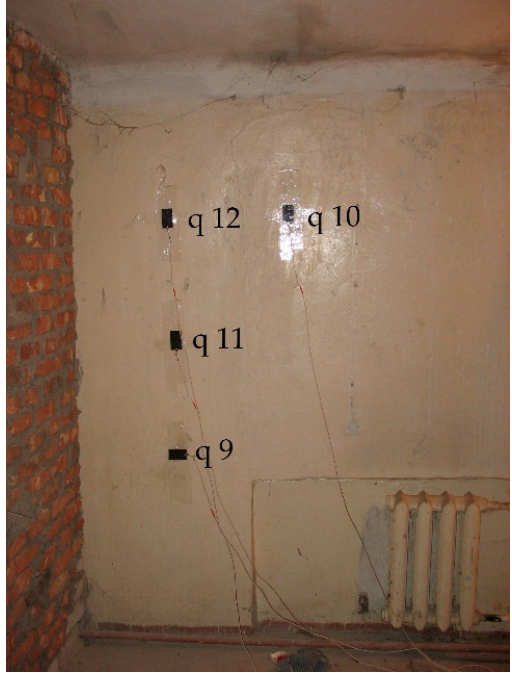
8 of 17 Figure 3. Thermal images of the external side of the building. Figure 4. Thermal images of the external side of the building before installing heat flux sensors. The heat flux sensors were placed on the wall using the contact thermal grease in